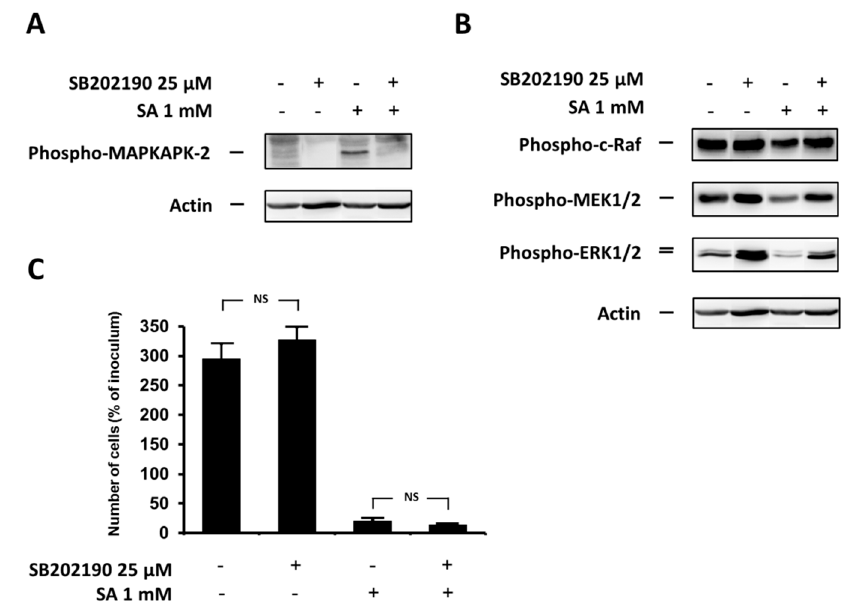
Figure 3. Effect of the specific p38 MAPK inhibitor, SB202190, (see “Materials and Methods”) and the effect of stearic acid (SA) on ( A ) the level of phospho-MAPKAPK-2 (substrate of p38 MAPK); ( B ) the level of phospho-c-Raf, phospho-MEK1/2, phospho-ERK1/2 (the ERK signaling pathway); and ( C ) cell growth and viability of NES2Y cells. Cells incubated without the inhibitor represented control cells. After 12 h of incubation (see “Materials and Methods”) ( A , B ), the level of individual proteins was determined using Western blot analysis and the relevant antibodies (see “Materials and Methods”). A monoclonal antibody against human actin was used to confirm equal protein loading. The data shown were obtained in one representative experiment from three independent experiments. When assessing cell growth and viability ( C ), cells were seeded at a concentration of 2 × 10 4 cells/100 µL of culture medium per well of 96-well plate (see “Materials and Methods”). The number of living cells was determined after 48 h of incubation. Each column represents the mean of four separate cultures ± SEM. NS (non-significant) when comparing the number of control cells and cells treated with SB202190 as well as when comparing the effect of SA alone and applied together with SB202190.